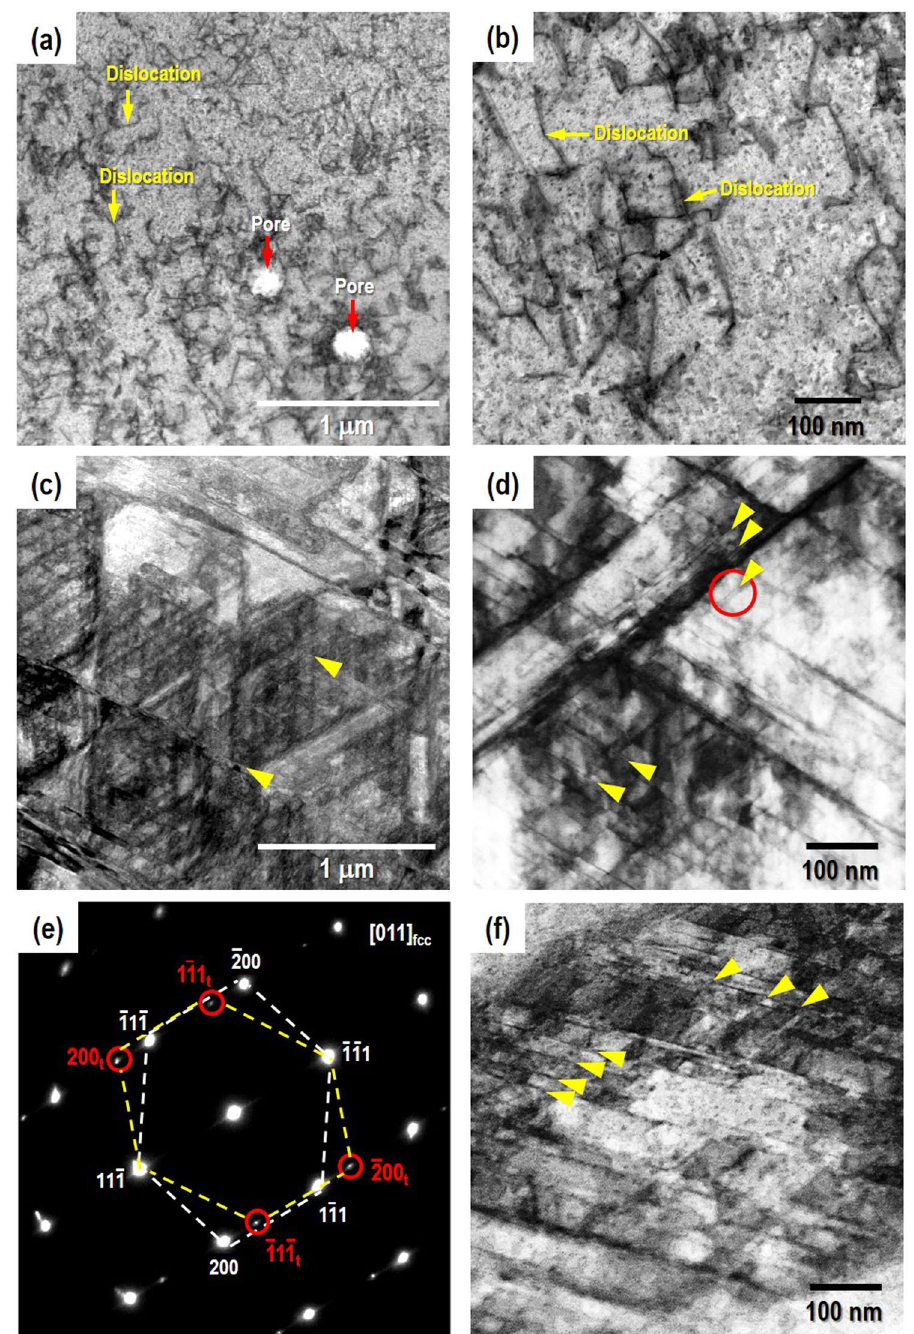
Figure 6. BF-STEM images along the 〈 101 〉 zone axis showing dislocations in as built ( a , b ) and multiple slip systems in deformed (engineering strain, ε = 58%) with LSR (2 × 10 − 5 s − 1 ) ( c , d ) AM CrCoNi alloy. Marked twin spots in selected area diffraction (SAD) pattern (e) taken at the red circle in ( d ). Note that ( f ) is taken from deformed ( ε = 47%) with HSR (2 × 10 − 3 s − 1 ) AM CrCoNi alloy